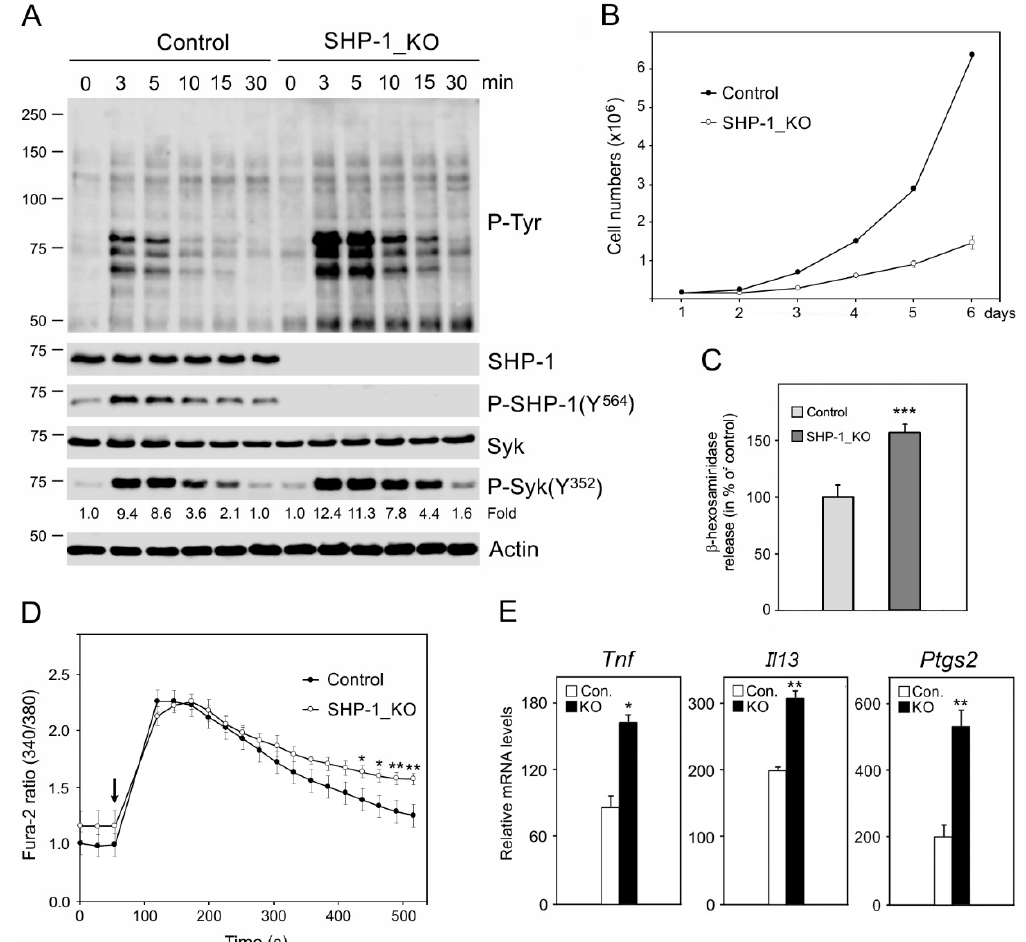
Figure 5. The characterization of cells lacking SHP-1. ( A ) The immunoblot characterization of control BMMCs and BMMCs without SHP-1 (SHP-1_KO): The cells were activated by Fc ε RI